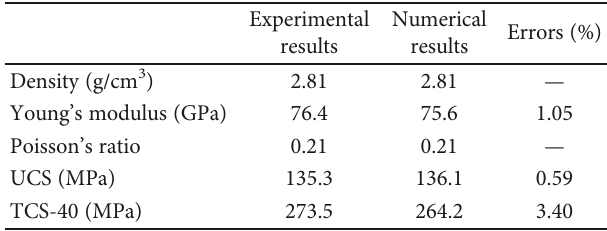
Table 2: Laboratorial and numerical macromechanical behavior of the marble specimen.